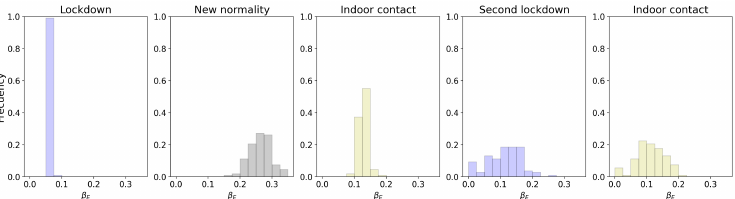
Figure 25. Histogram of the 107 different regions of Italy. The value of β E at the different levels of lockdown registered in